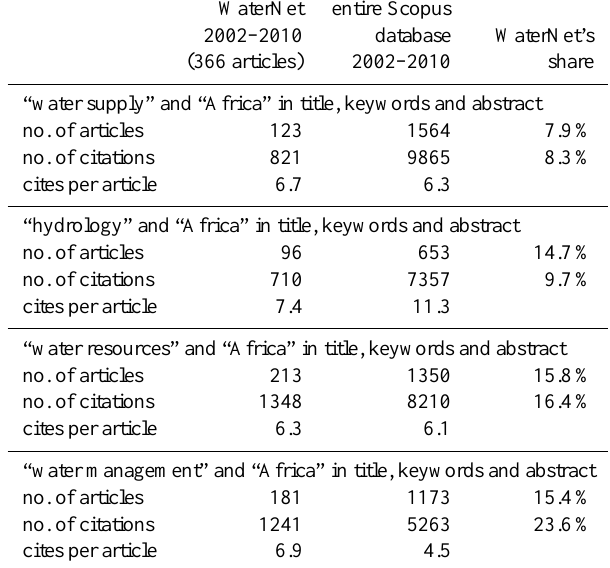
“water supply” and “Africa” in title, keywords and